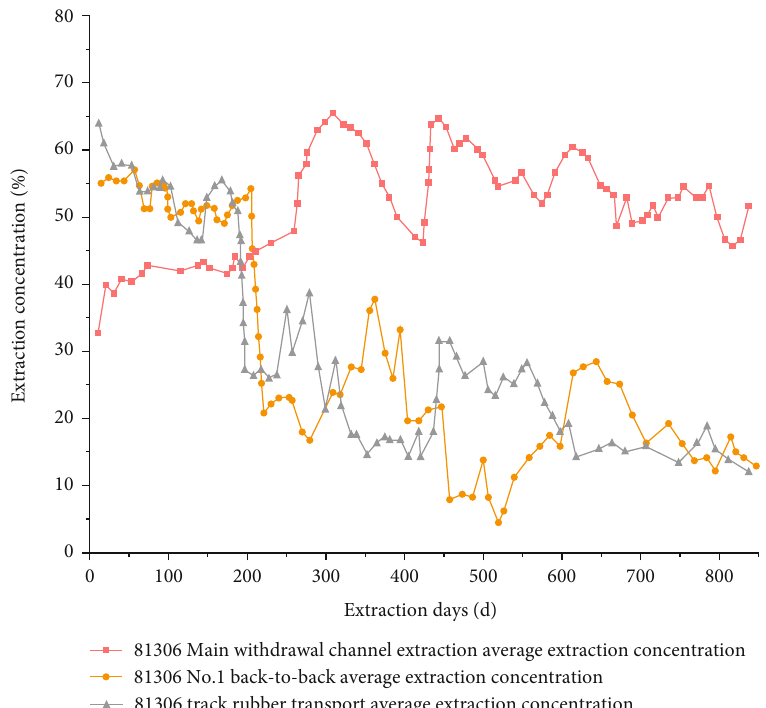
Figure 10: Comparison of extraction concentration between directional drilling and conventional drilling in working face 81306.